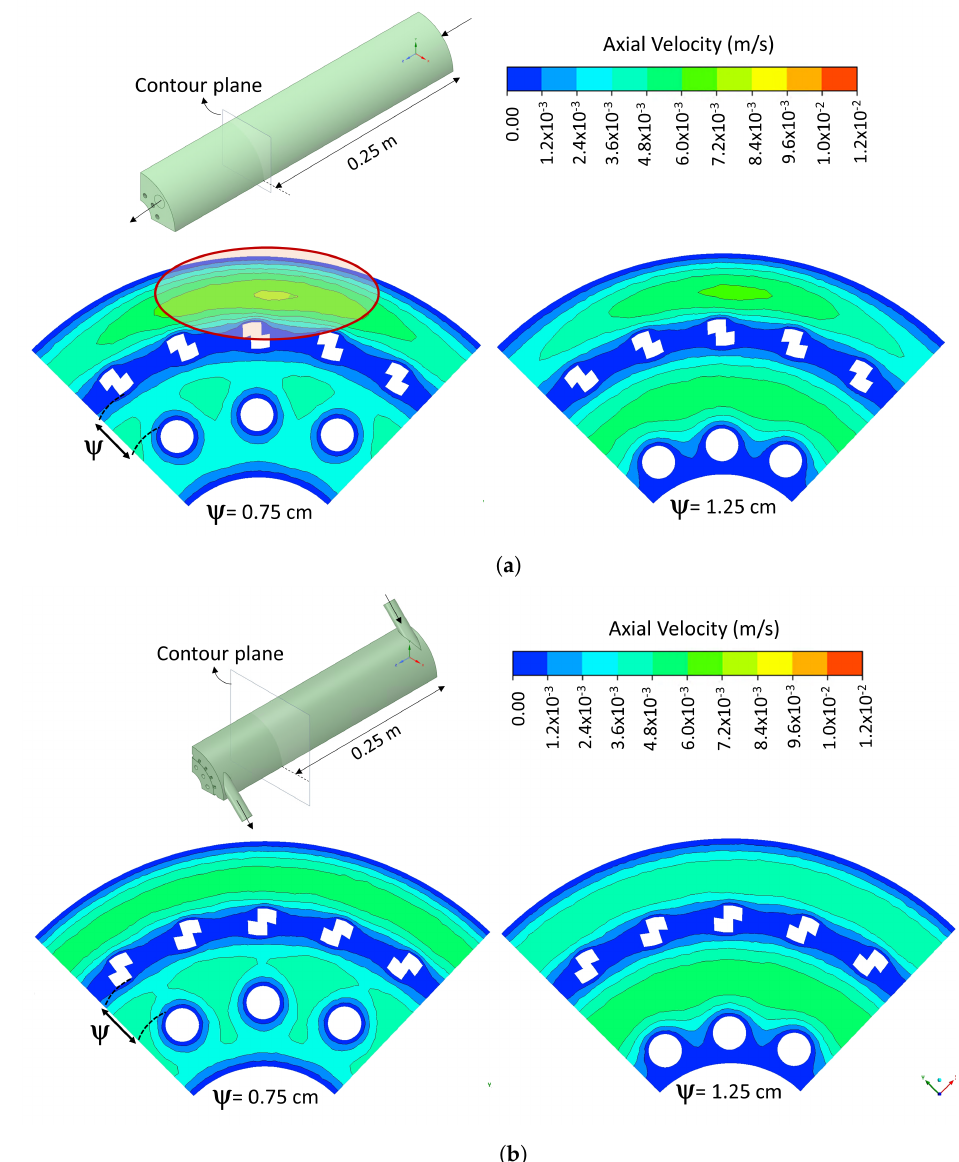
Figure 10. Cross-sectional contour of velocity magnitude with ψ equal to 0.75 and 1.25 cm for ( a ) AF and ( b ) TF configuration in laminar